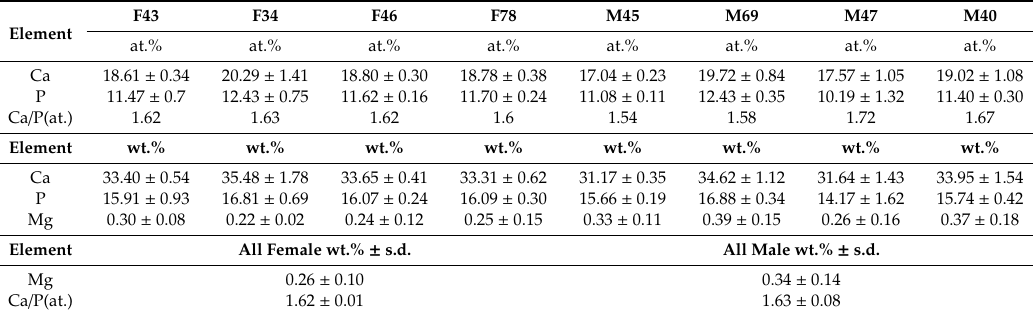
Table 2. EDS elemental composition of human bone specimens.